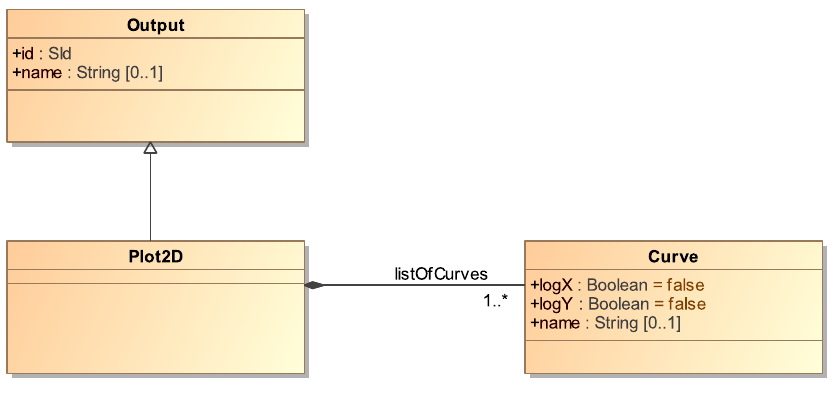
Figure 2.40: The SED-ML Plot2D class